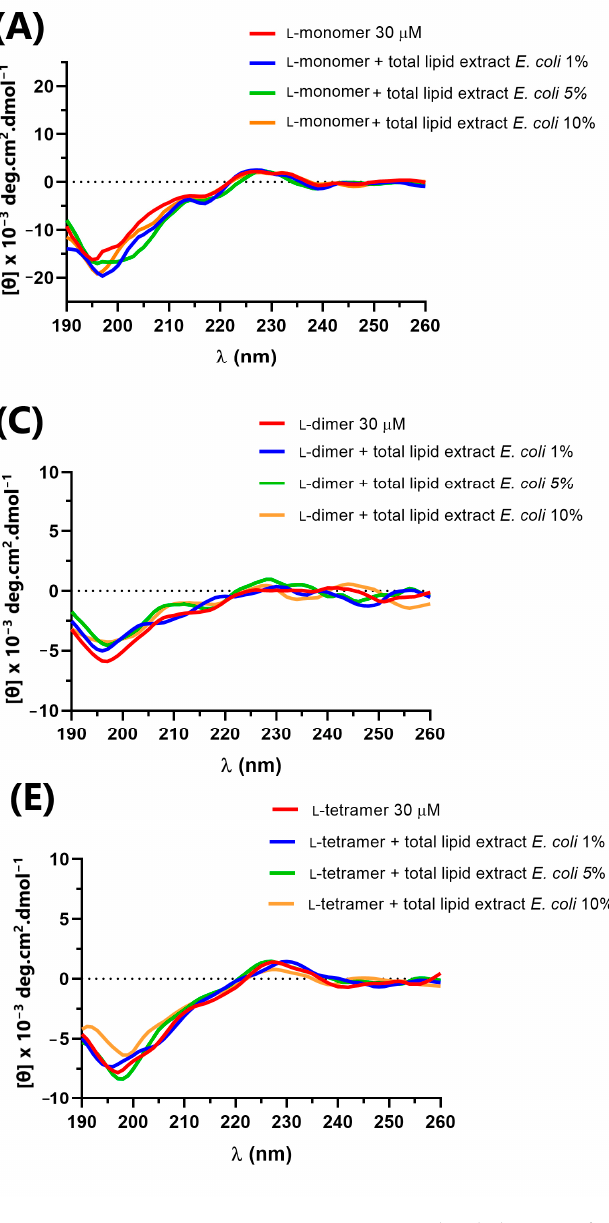
Figure 5. Circular dichroism of peptides: ( A ) L-monomer, ( B ) D-monomer, ( C ) L-dimer, ( D ) D-dimer, ( E ) L-tetramer, and ( F ) D-tetramer at 30 µ M in PBS and in the presence of 1, 5 and 10% E. coli total lipid extract.